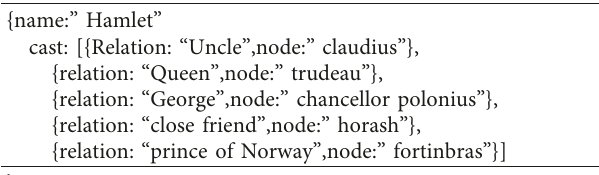
Figure 7: The framework of the knowledge graph visualization query system. Table 7: JSON form example of person entity and relation entity.